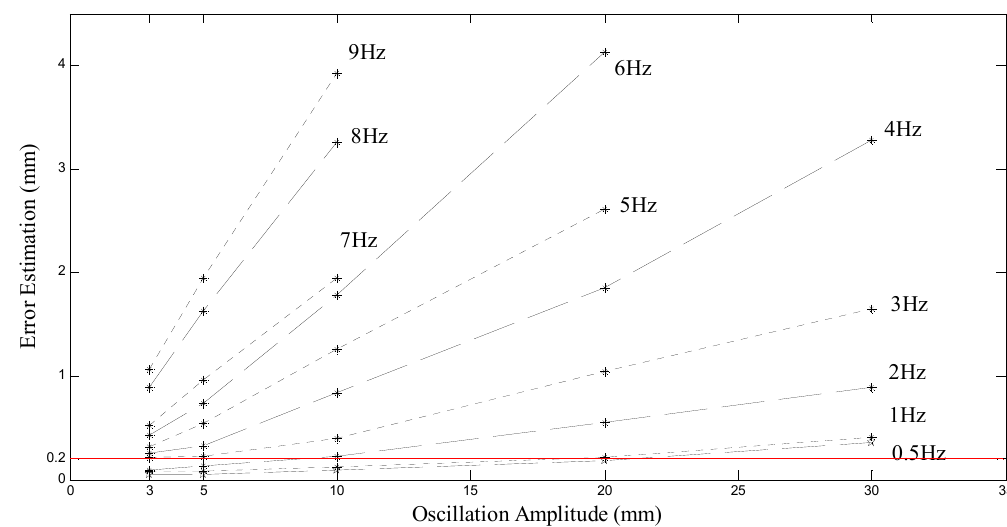
Figure 8 . Illustrative diagrams of absolute amplitude errors of different segments. Figure 8. Illustrative diagrams of absolute amplitude errors of different segments.